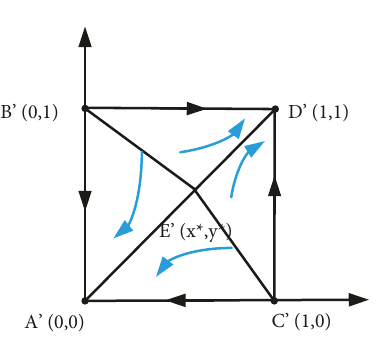
Figure 3: Dynamic phase